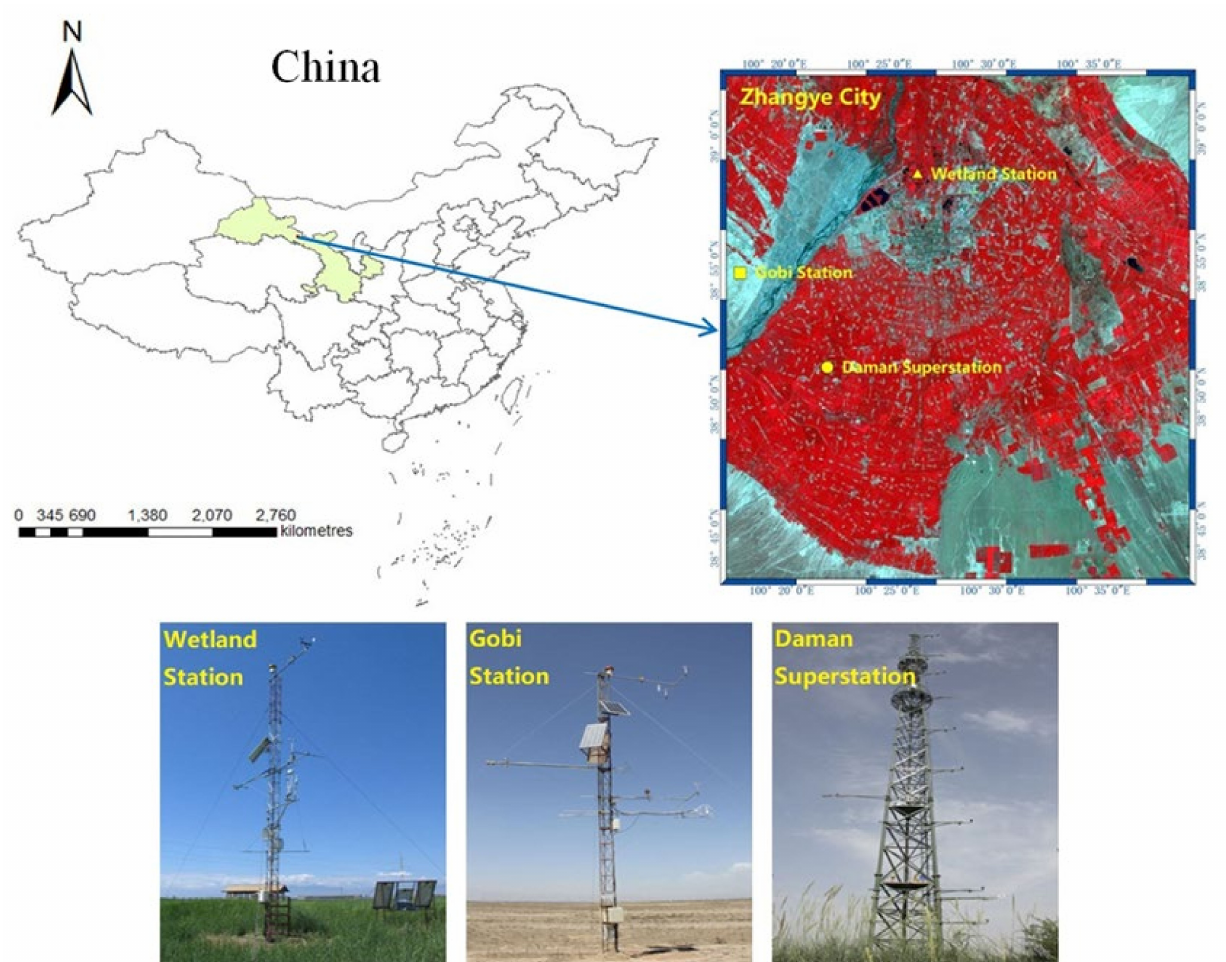
Figure 1. Location of the study area and stations’ spatial